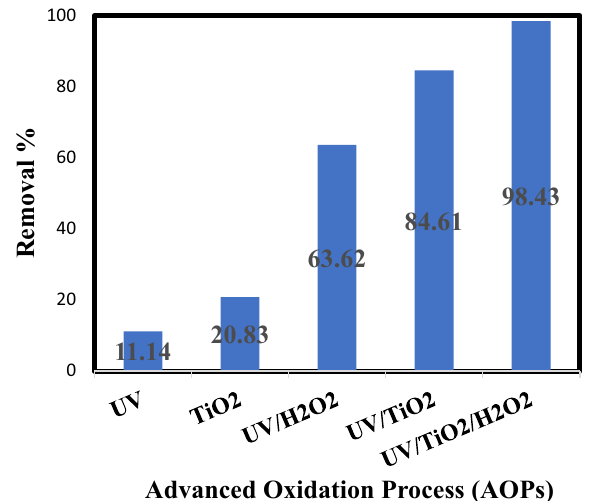
Figure 8. Influence of UV, TiO 2 photocatalysis, UV/TiO 2 , UV/H 2 O 2 , and TiO 2 /UV/H 2 O 2 , processes on an oil elimination percentage.